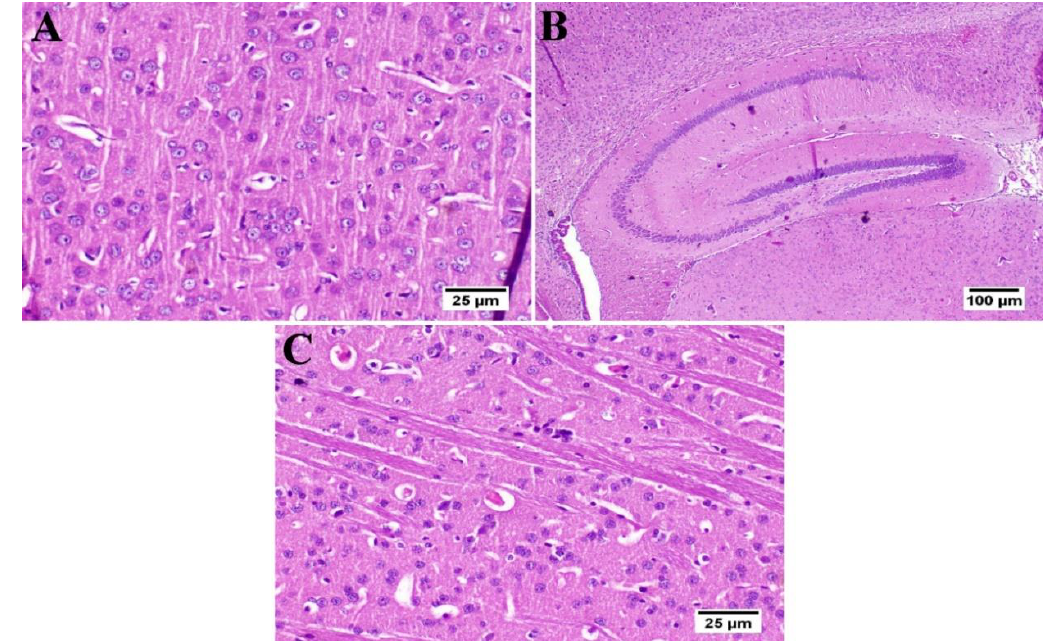
Figure 7. Histology of the brain of normal mice which received umuhengerin (n = 3) (H&E). Normal mice receiving umuhengerin (group II) showed a normal histological structure of different neurons in the ( A ) cerebral cortex, ( B ) hippocampus and ( C ) striatum.